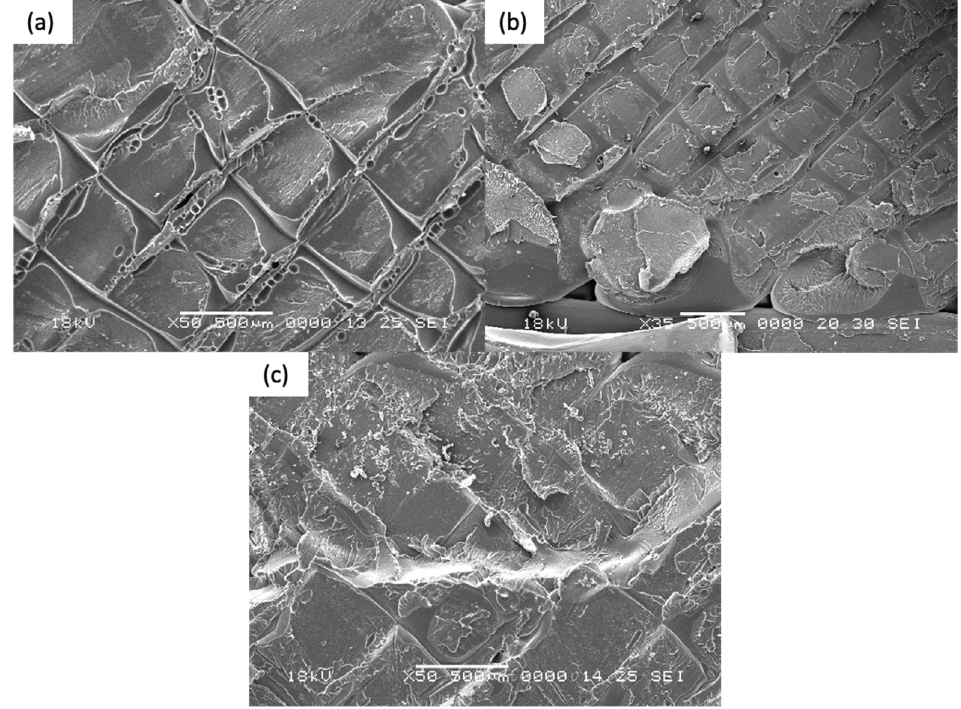
Figure 13. Fracture surface for ( a ) Coupon 3, ( b ) Coupon 4, and ( c ) Coupon